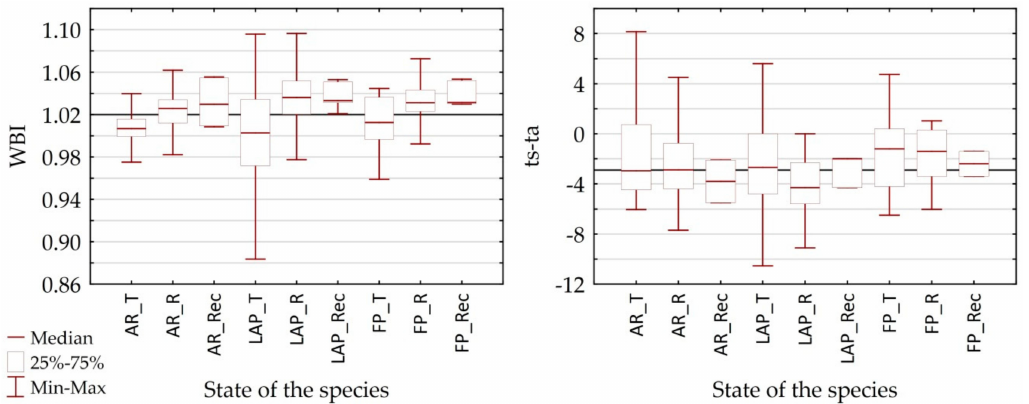
Figure 5. Values of indices: WBI (Water Band Index), ts-ta temperature index, n = 49,375 per